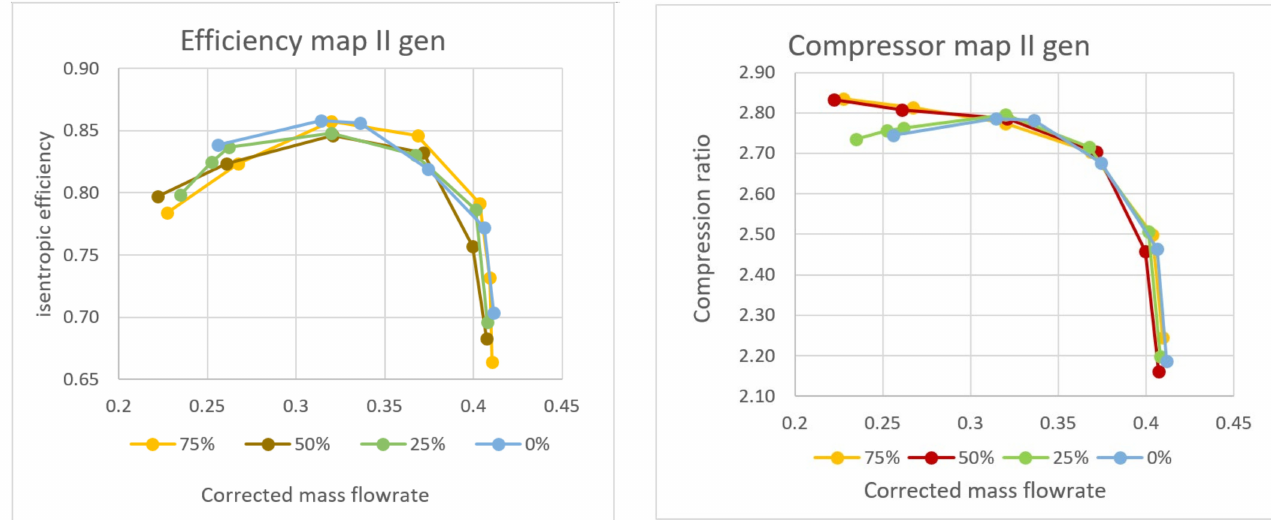
Figure 28. Graphical results of second generation DOE campaign. Isentropic efficiency-Corrected mass flowrate Plot ( left ), Characteristic map of the second generation of impellers ( right